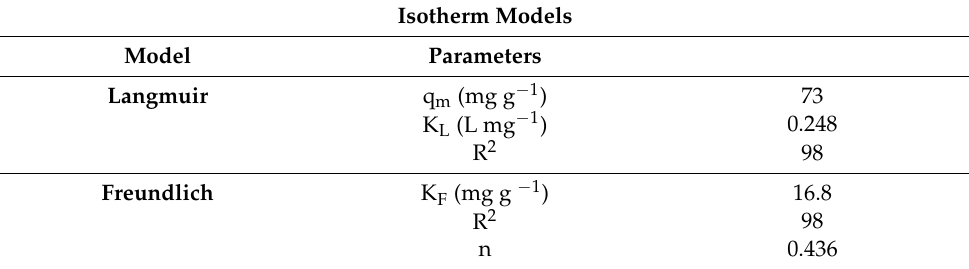
Table 7. Langmuir and Freundlich isotherm parameters for anionic dye